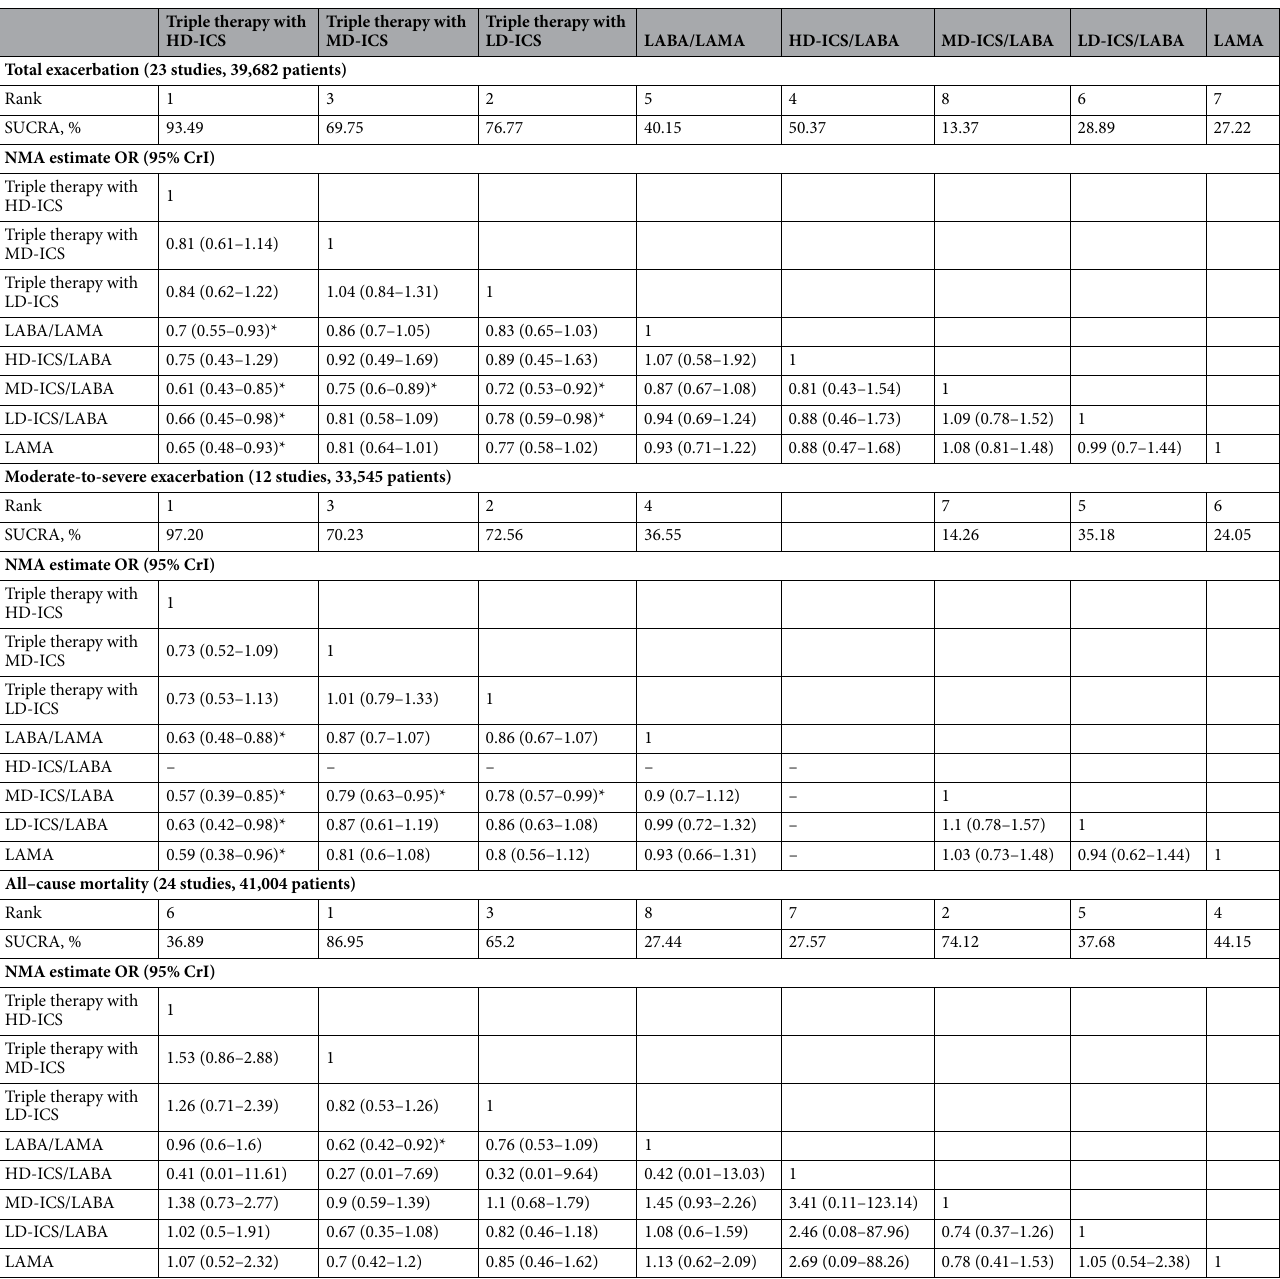
Table 2. Acute exacerbation and mortality associated with different inhaled therapies. CrI: credible interval; HD: high-dose; ICS: inhaled corticosteroid; LABA: long-acting beta-agonist; LAMA: long-acting muscarinic antagonist; LD: low-dose; MD: medium-dose; NMA: network meta-analysis; OR: odds ratio; SUCRA: surface under the cumulative ranking curve. Median OR with 95% CrI was calculated as a row to column ratio. If the OR is significantly lower than 1, the drug in the left row is considered to be more beneficial than the other drug in the upper column. *Indicates that the posterior probability is either less than 0.025 or more than 0.975, which is considered statistically